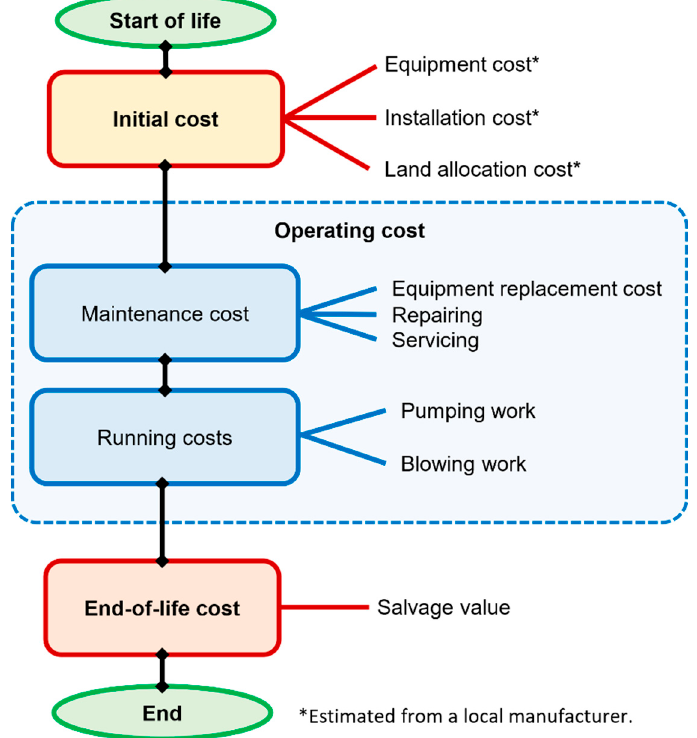
Figure 13. A framework of life-cycle-cost analysis adapted for the economic assessment of the desalination plant.